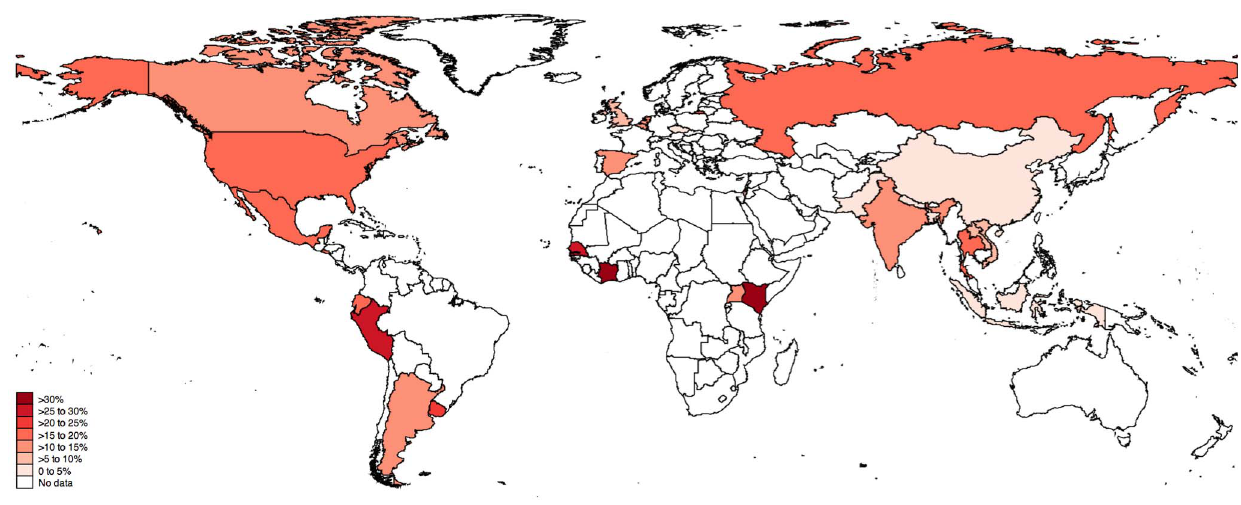
Figure 2. Pooled HIV prevalence by country among studies reporting biologically-confirmed HIV prevalence with a sample size of $ 50 (N=66).